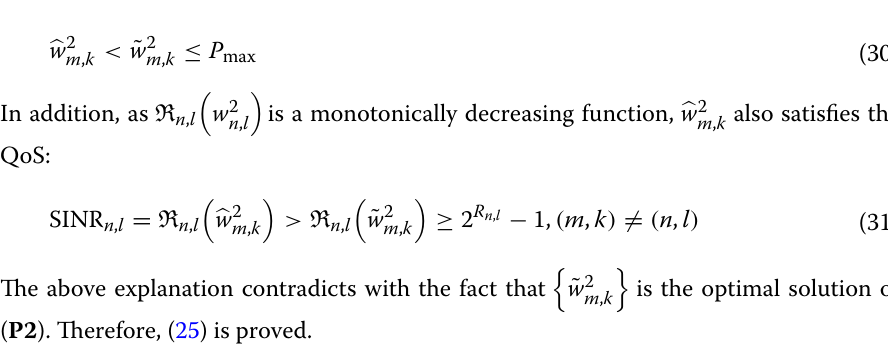
Table 1 Simulation parameters Parameters Value The noise power The length of square D 500 m The number of groups M 2 The error propagation factor ε m , k 0.01 The number of users in a group U